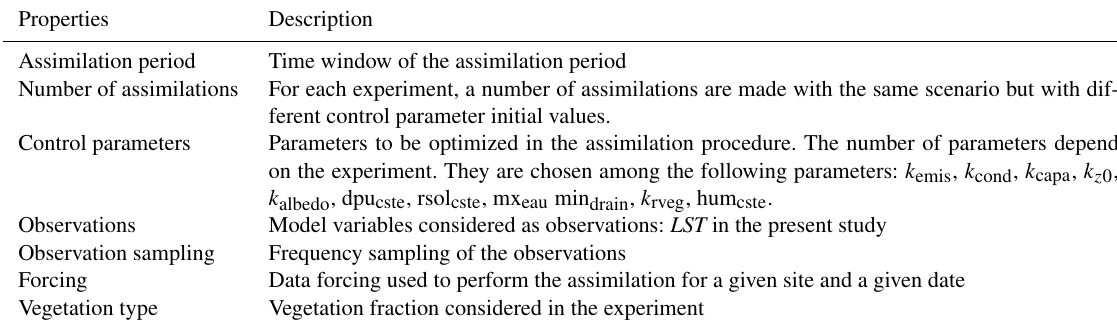
Table 3. Scenario properties and description.